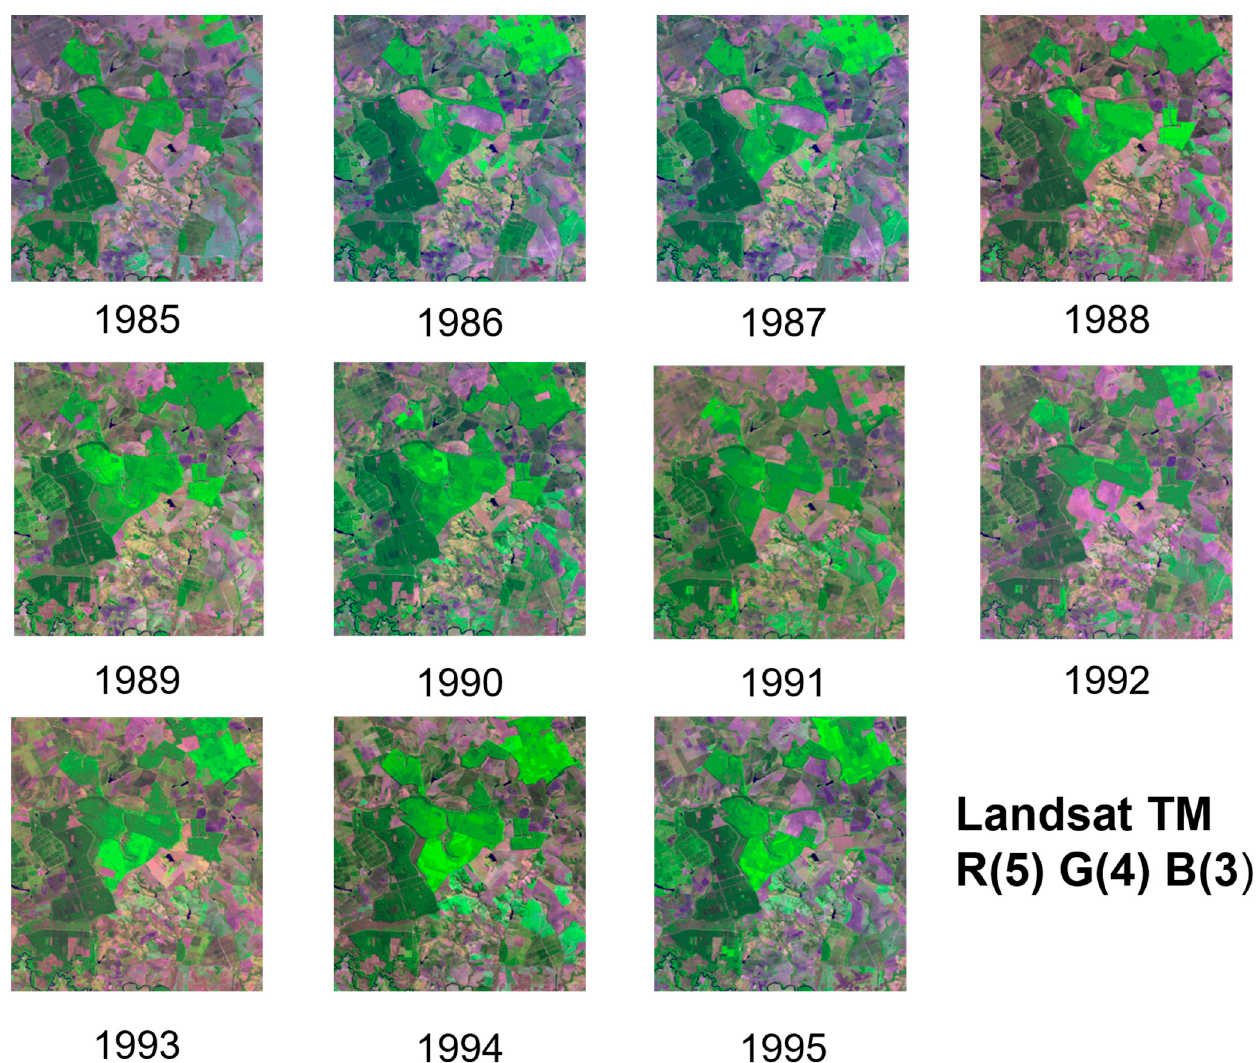
Figure 17. Landsat TM dataset (1985–1995) over the pilot area.